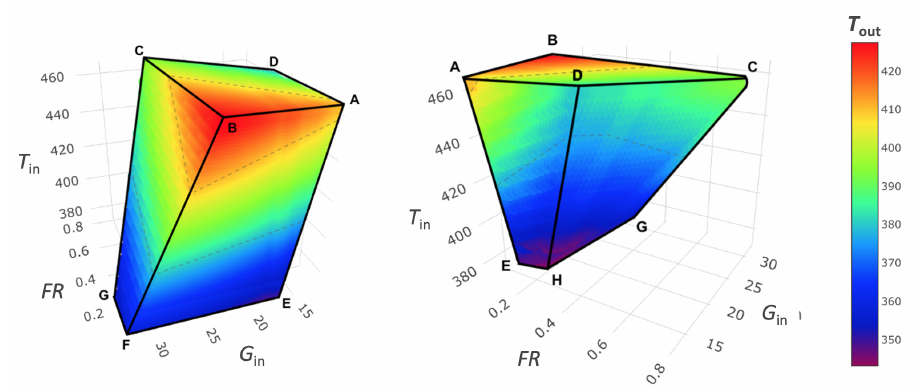
Figure 8. Design space volume and iso-level curve of T out , created with explicitated G in .